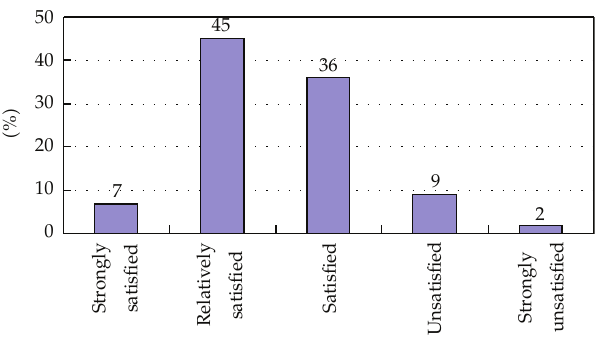
Figure 7: Satisfaction for travel time.